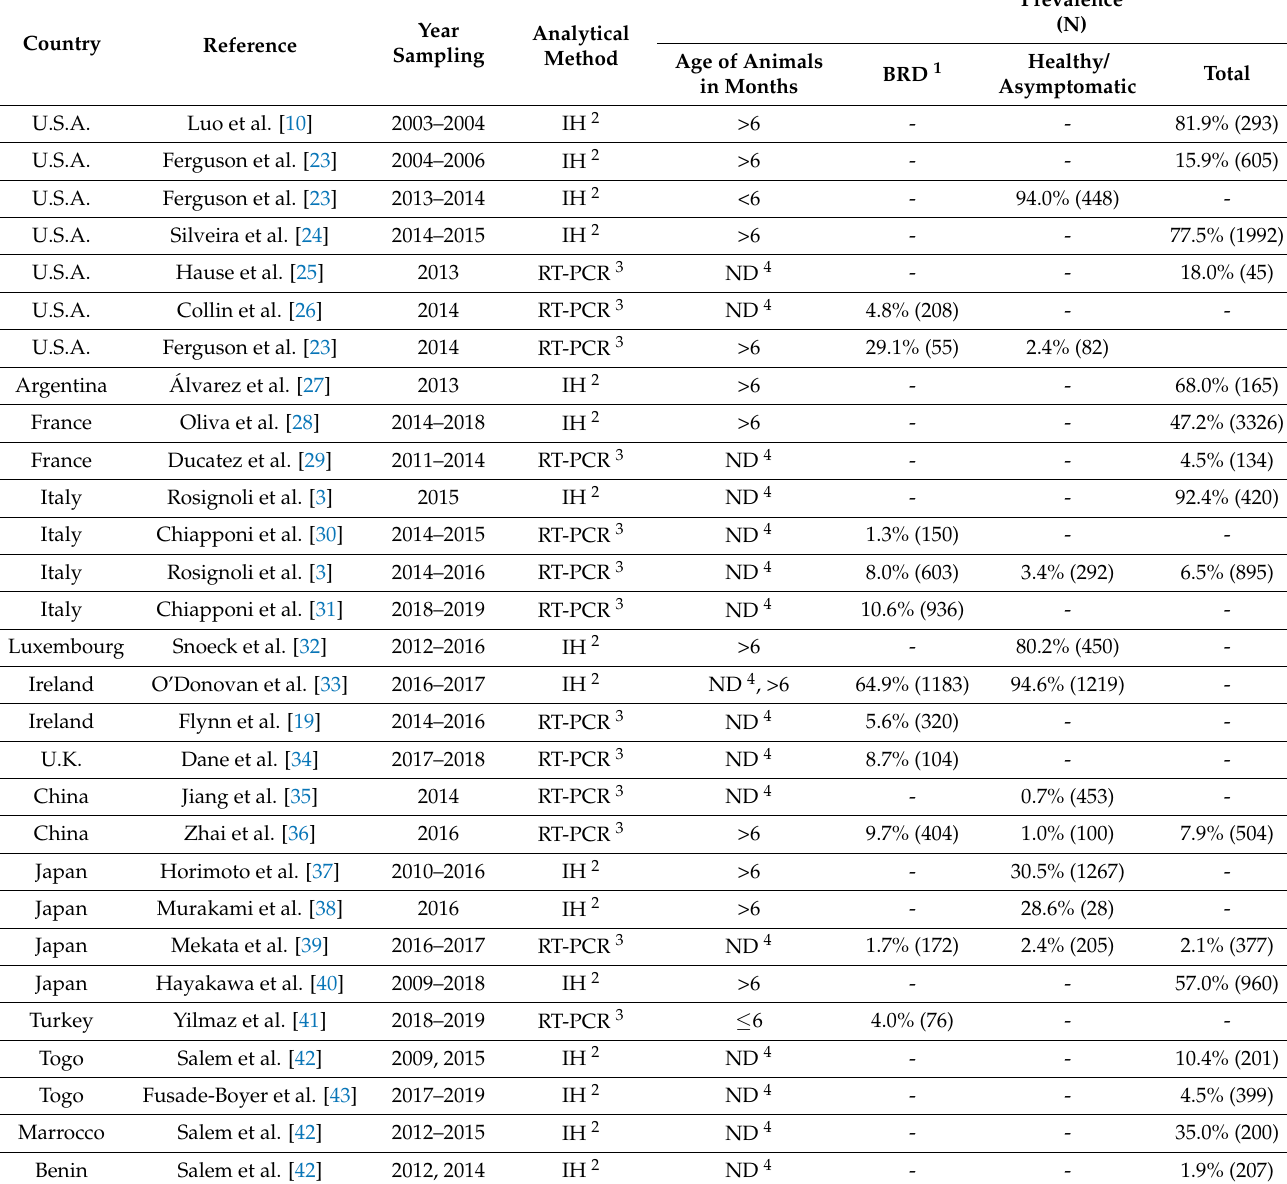
Table 2. Summary of IDV prevalence (%) by country, with the age of the animals expressed as >6 months old, =6 months old or <6 months old, year of the sampling, analytical method, and refer- ences. Sample size is reported in brackets. Prevalence is reported as total if the study did not detail if the animals were showing clinical signs compatible with BRD. Prevalence is reported as BRD if the study was on animals with clinical signs and as healthy/asymptomatic if the study reported the results on animals without BRD clinical